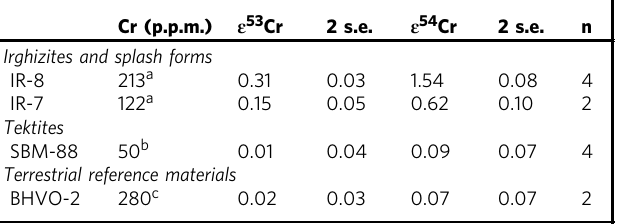
The letter n represents the number of individual runs where each single run consists of four successive measurements in static mode with isotopes shifted by one mass unit in the Faraday detectors a Data from ref. 28 b Data from ref. 57